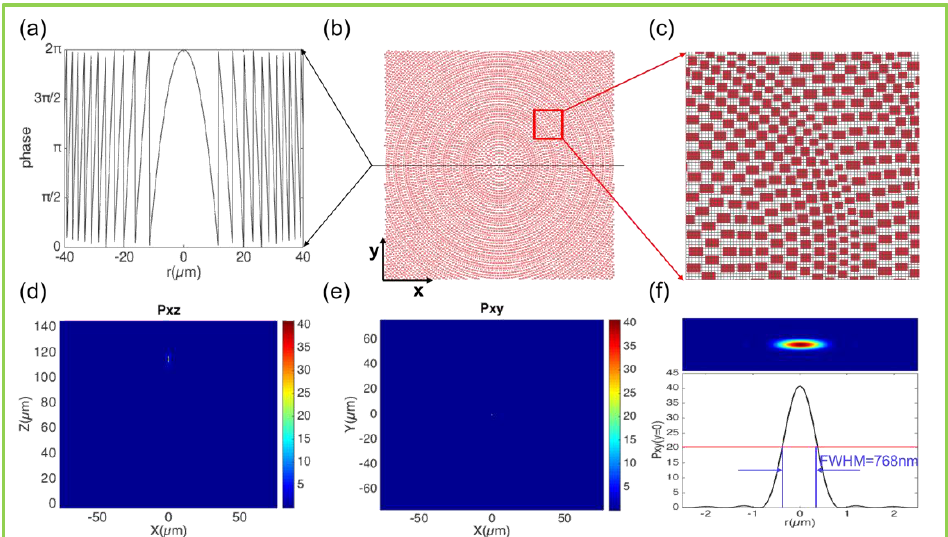
Figure 5. Metasurfaces of parabolic lens. ( a ) Phase-distribution function of the metalens in radial direction. ( b ) Top view of metalens composed of the eight meta-atoms in Figure 3, introducing the digital phase shift with π/4 increments covering the 2π range. ( c ) Partial enlarged details of the metasurface, which is marked by the red box in (b). ( d , e ) Power distributions of the focusing spot in the x–z (y = 0 nm) and x–y (z = 115.1 µm) planes, respectively. ( f ) Full width at half maximum (FWHM) of the focusing spot.